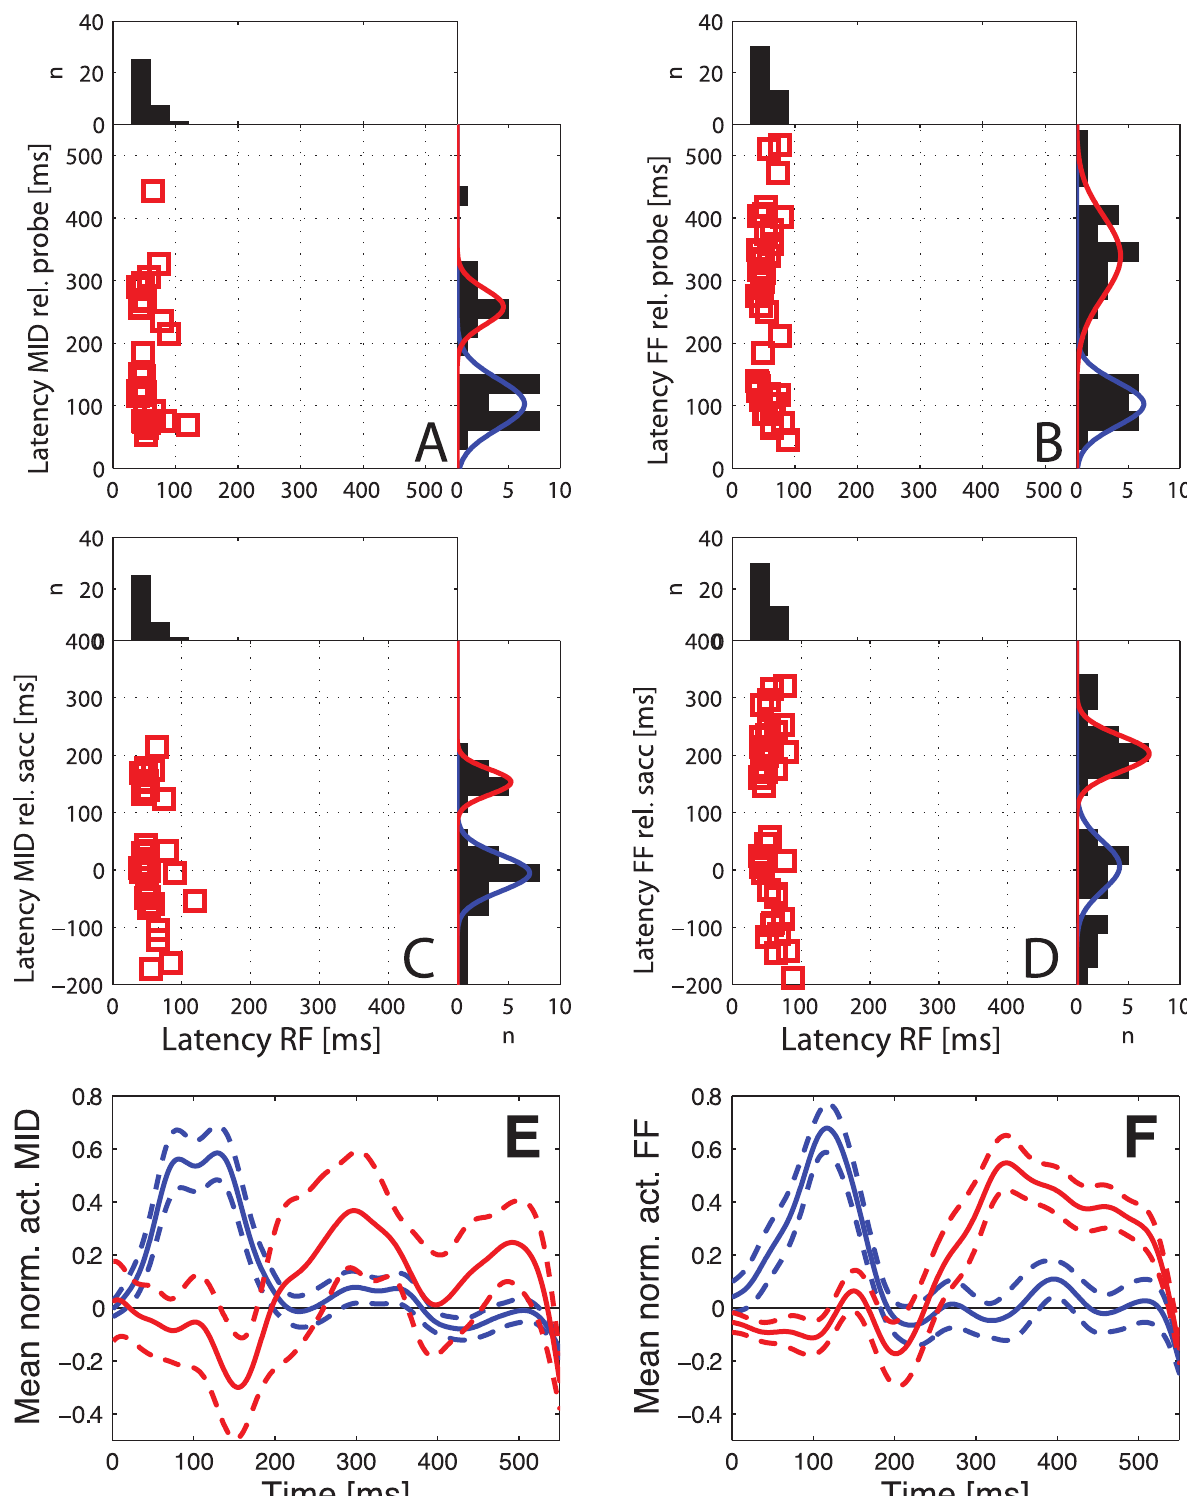
Figure 3. Latencies of visual and extraclassical responses. Latencies of the responses to probes presented in the RF, MID and FF positions across the two monkeys. The latencies for the RF-probes are always shown relative to the onset of the probe, while responses to the MID- and FF- probes are shown relative to the onset of the probe (A and B) or relative to saccade onset (C and D). Histograms aligned to each axis show the distributions of latencies on this axis. A sum of two Gaussians was fitted to the distribution of remapping latencies. The two resulting Gaussians are